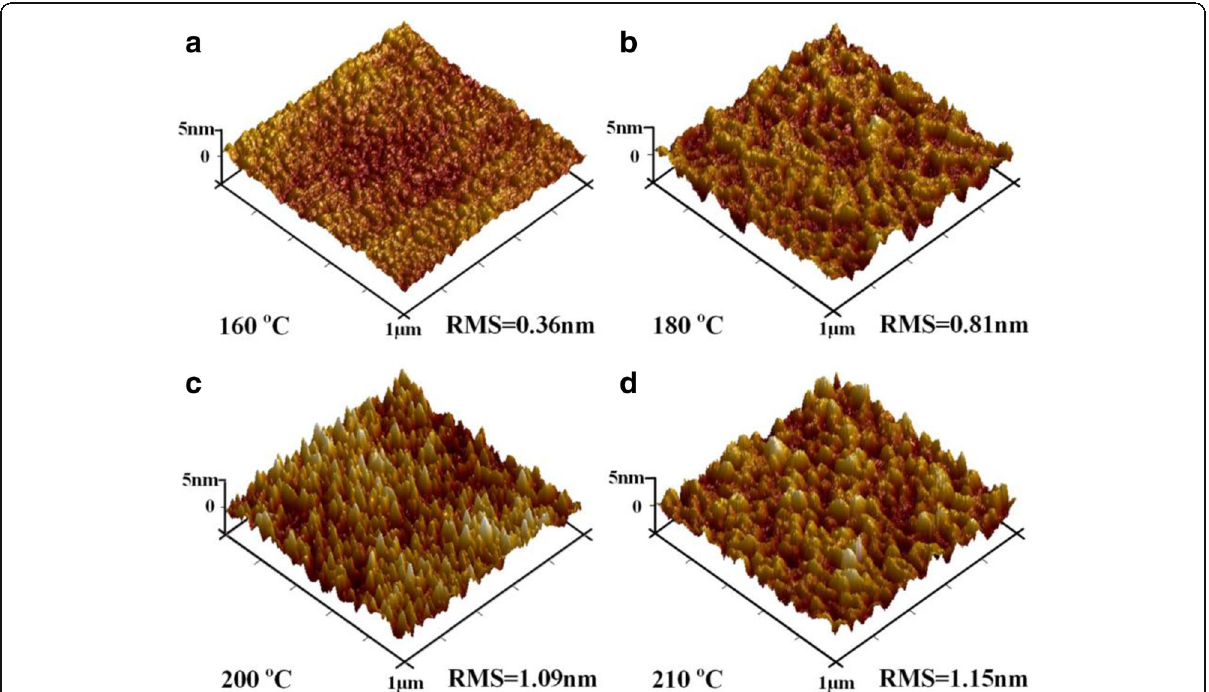
Fig. 3 The AFM images of the In 2 O 3 films deposited at different temperatures: a 160 °C, b 180 °C, c 200 °C and d 210 °C. The deposition cycles were fixed at 250 for each